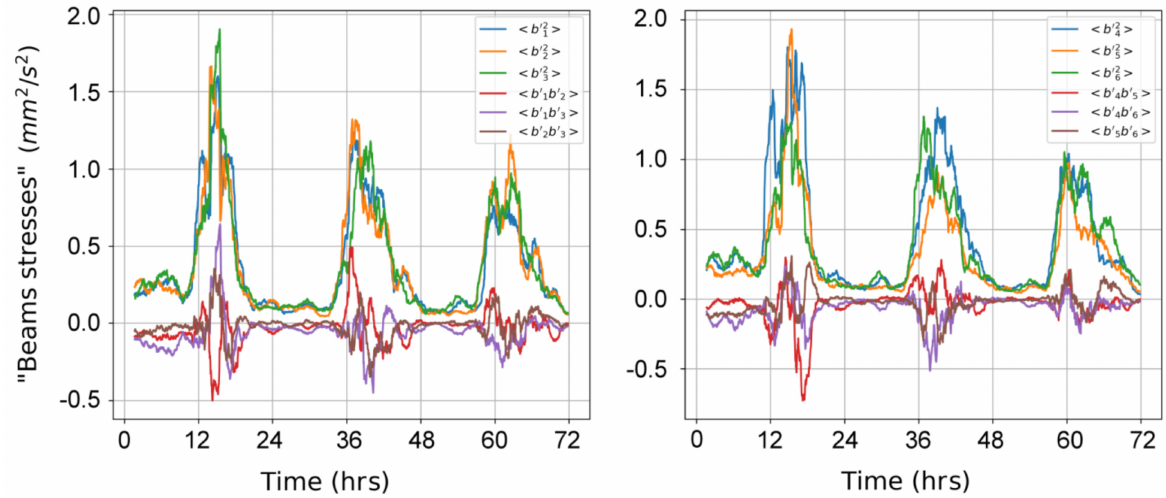
Figure 3. The calculated dynamics of beam velocity intensities and interbeam velocity correlations for both devices. Time readings from 4 April,